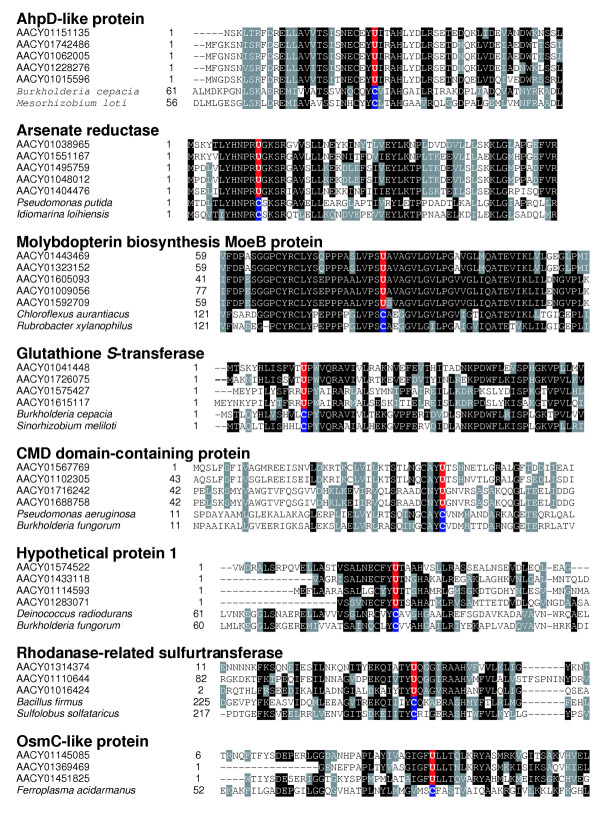
Multiple sequence alignments of new selenoproteins and their Cys homologs. The alignments show Sec-flanking regions in detected proteins. Both selenoprotein sequences detected in the Sargasso Sea database and their Cys-containing homologs present in indicated organisms are shown. Conserved residues are highlighted. Predicted Sec (U) and the corresponding Cys (C) residues in other homologs are shown in red and blue background, respectively. Sequence alignments were generated with ClustalW and shaded by BoxShade v3.21.